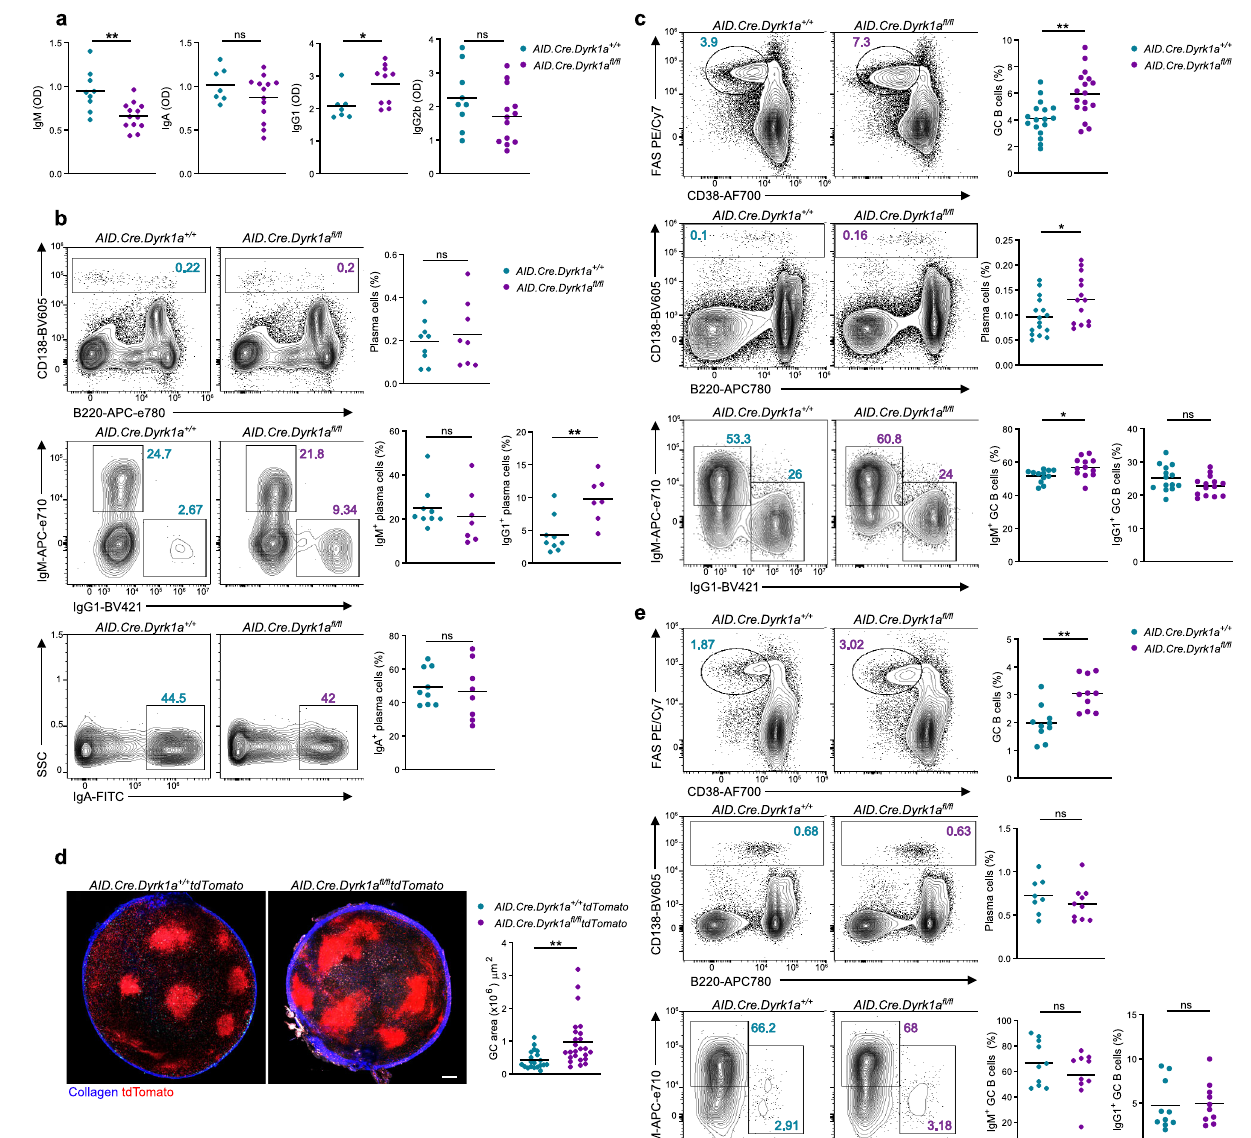
pulated mice; two independent experiments, two-tailed Student ’ s t